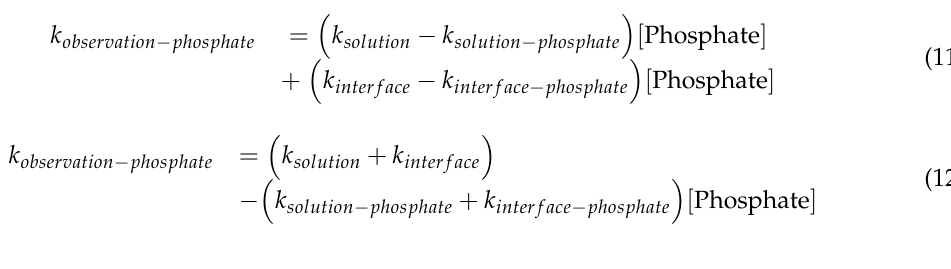
Figure 12. Phosphate concentration and linearity of reaction rate constants.